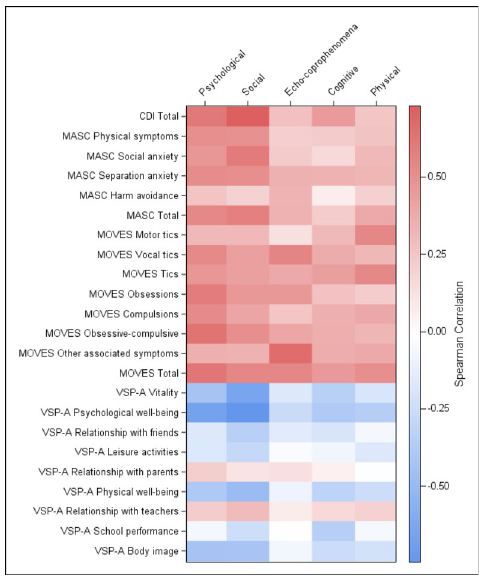
Fig 2. Convergent validity for GTS-QOL-French-Ado. Correlations represented on a HEATMAP: in red, positive correlations and in blue, negative correlations. Graduation in the colour indicates the strength of the correlation.